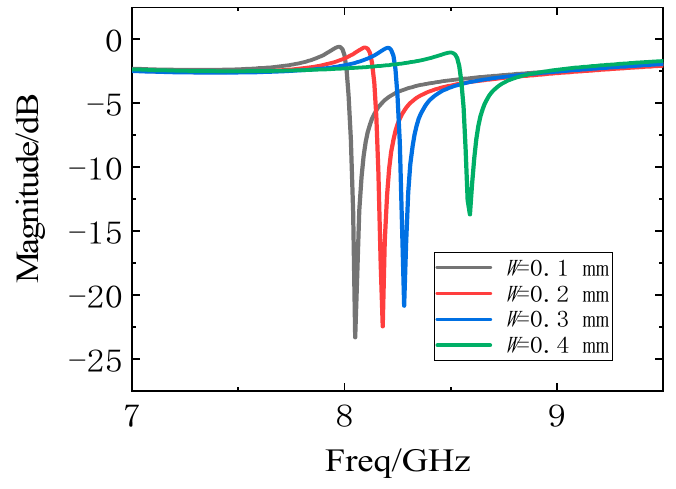
Figure 14. Resonance curves of U-shaped slot resonators with different slot widths.